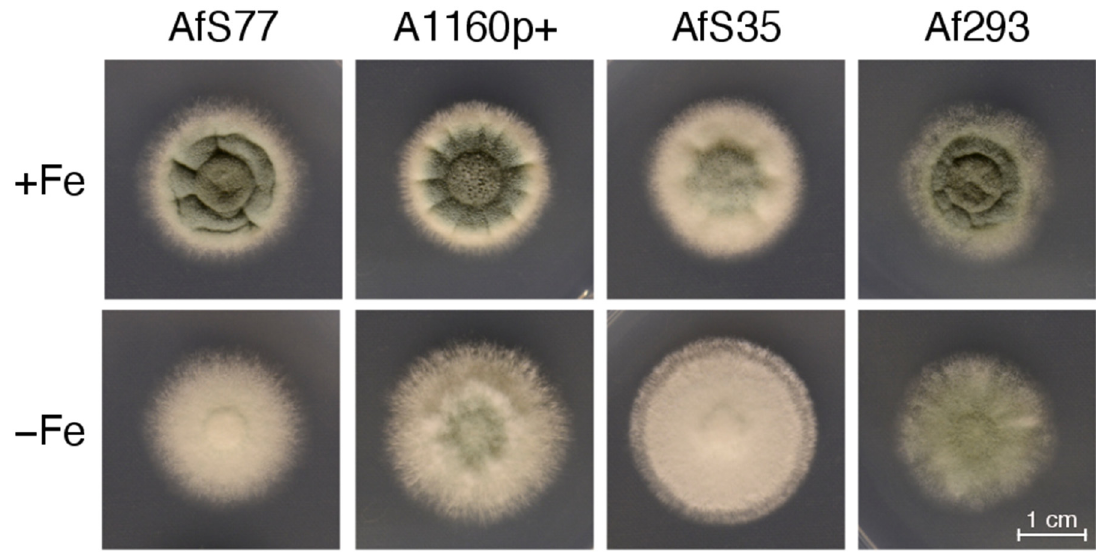
Figure 11. Colony morphology of A. fumigatus AfS77 compared to A1160p+, AfS35, and Af293 cultured for 48 h at 37 ◦ C under +Fe and − Fe conditions. For inoculation of fungal strains, suspensions containing 10 4 spores were dotted onto minimal media solidified with 1.5%